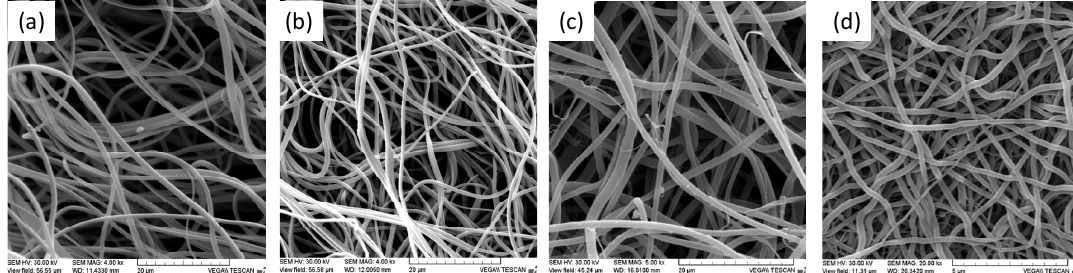
Figure 5. SEM images of the as-prepared pristine PVP ( a ) and of the PVP ( b ), PVP/Au, (2% wt) ( c ) PVP/Au, (9% wt) ( d ) electrospun fibrous mats obtained upon crosslinking. To verify the success of the crosslinking process, the thermally-treated membranes were immersed in water at ambient temperature for several days and subsequently, the UV-vis spectrum of the supernatant was recorded. As seen in Figure 6, no absorption signals corresponding to either PVP or Au NPs were observed. The absence of leaching phenomena was further supported by the photograph of the crosslinked PVP/Au electrospun fibrous mat immersed in water provided in the same figure.